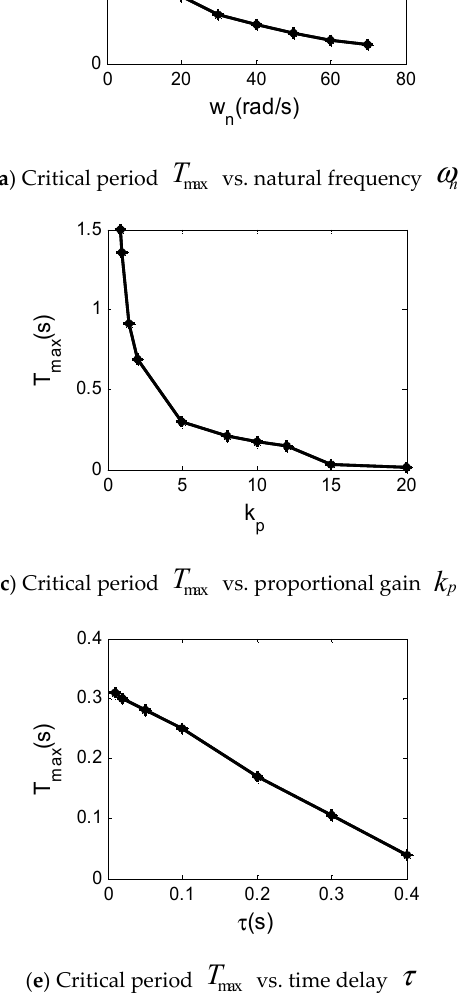
Figure 6. Factors influencing the critical period max